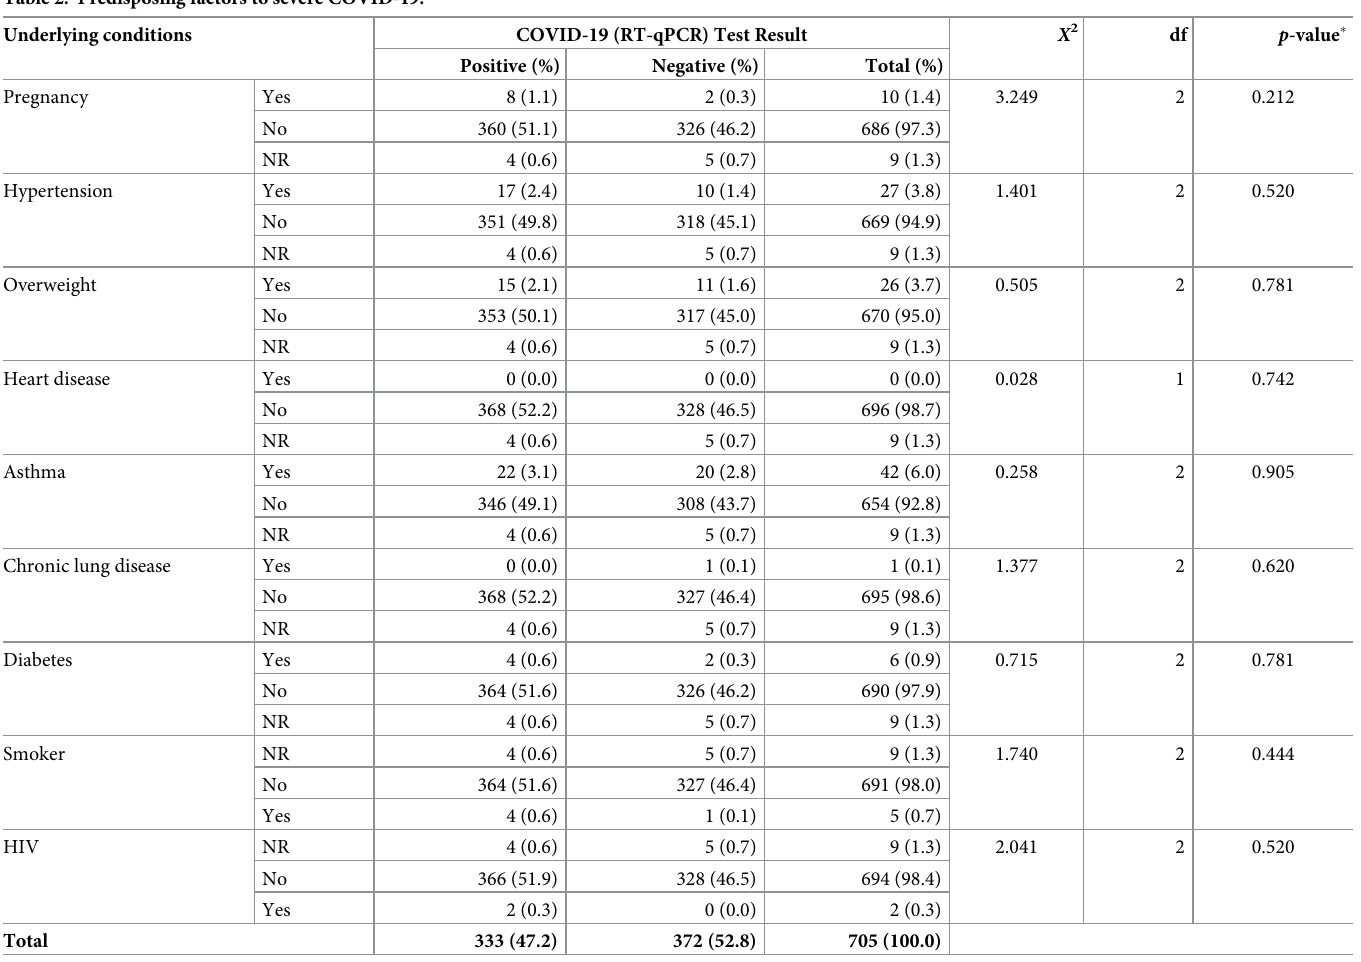
Table 2. Predisposing factors to severe